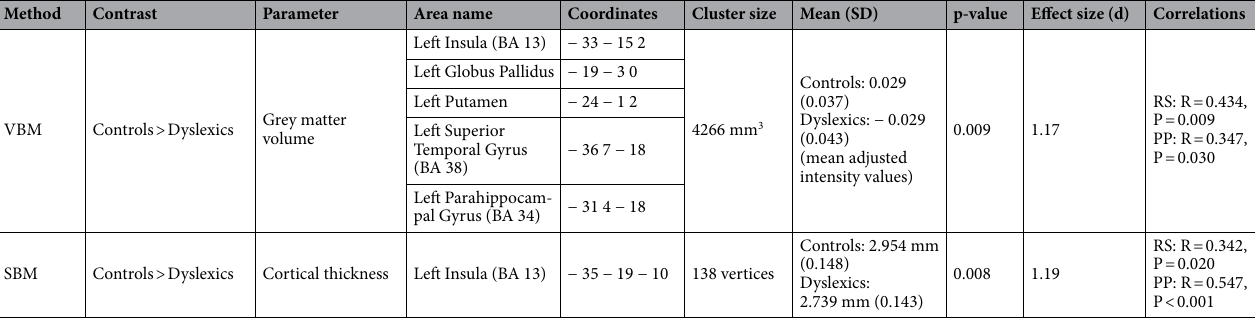
Table 3. Whole-brain VBM and SBM group comparison results. All results are corrected for nonstationarity and thresholded at a cluster-level FWE p < 0.05 threshold. Correlations are partial correlations with 2-tailed p-value (FDR) controlling for age, sex, TIV and PIQ for VBM, and age, sex, and PIQ for SBM. d Cohen’s d, BA, Brodmann area, PP phonological processing, RS reading score, SBM surface-based morphometry, SD standard deviation, VBM voxel-based